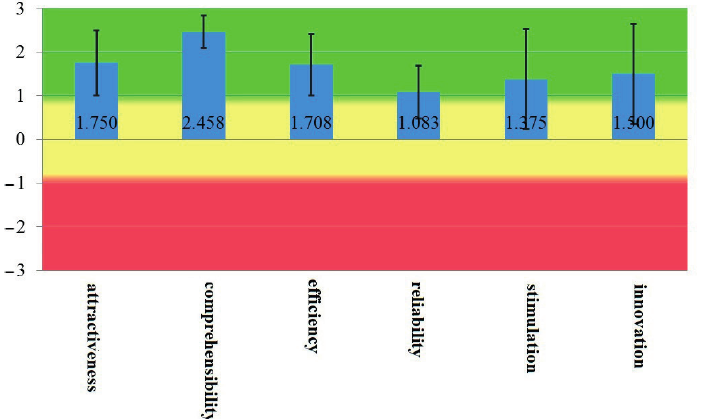
Figure 3. INKHUNTER evaluation results using user experience questionnaire method (source: created by the